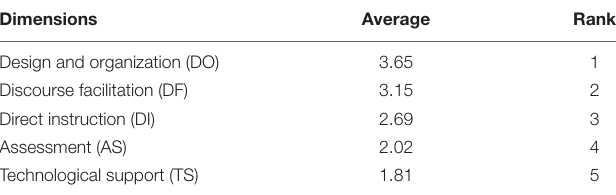
TABLE 7 | The perceived importance of the five dimensions of teaching presence. Dimensions Average